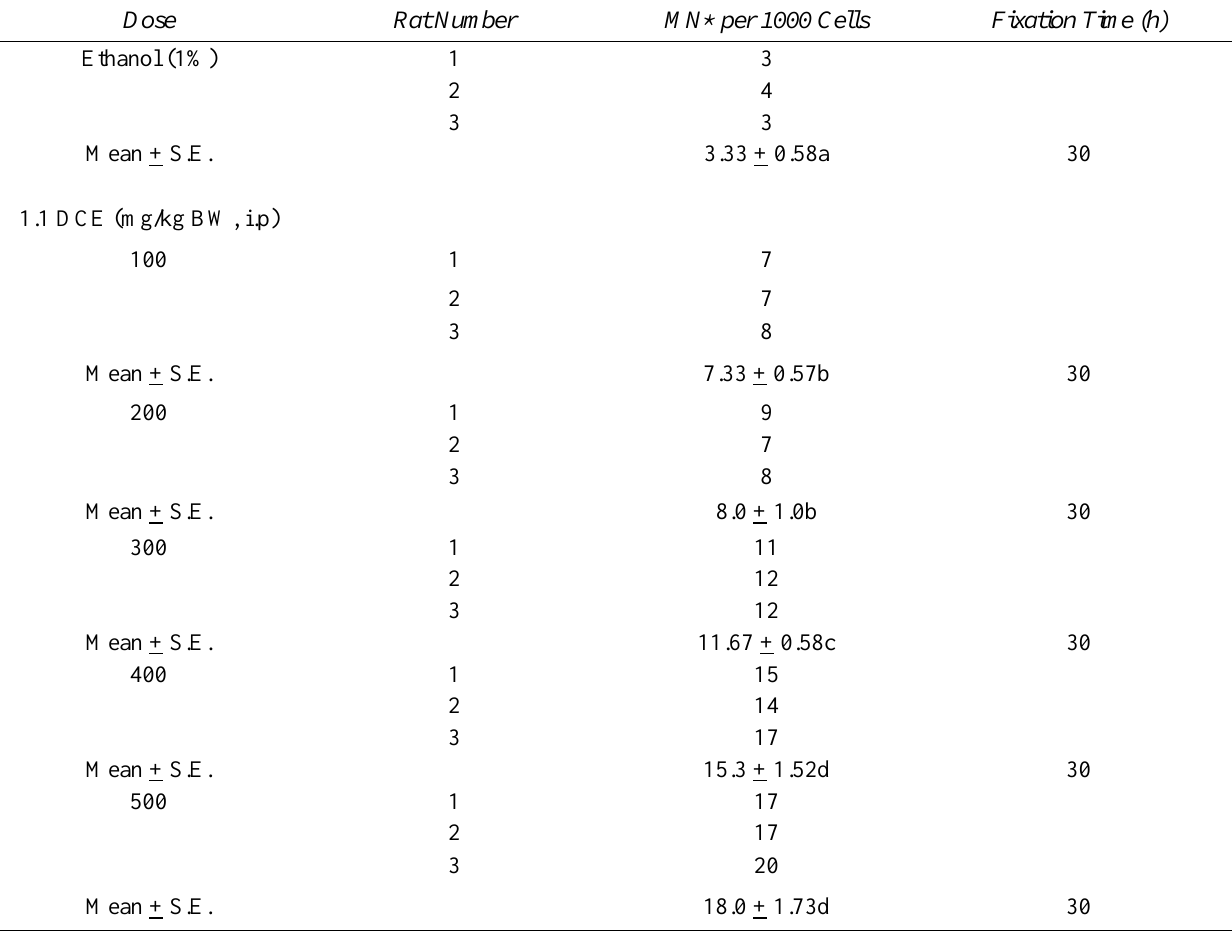
Table 2: Frequency of micronucleated cells in mice bone m rrow. Means followed by a common letter are not ignificantly different from each other at p